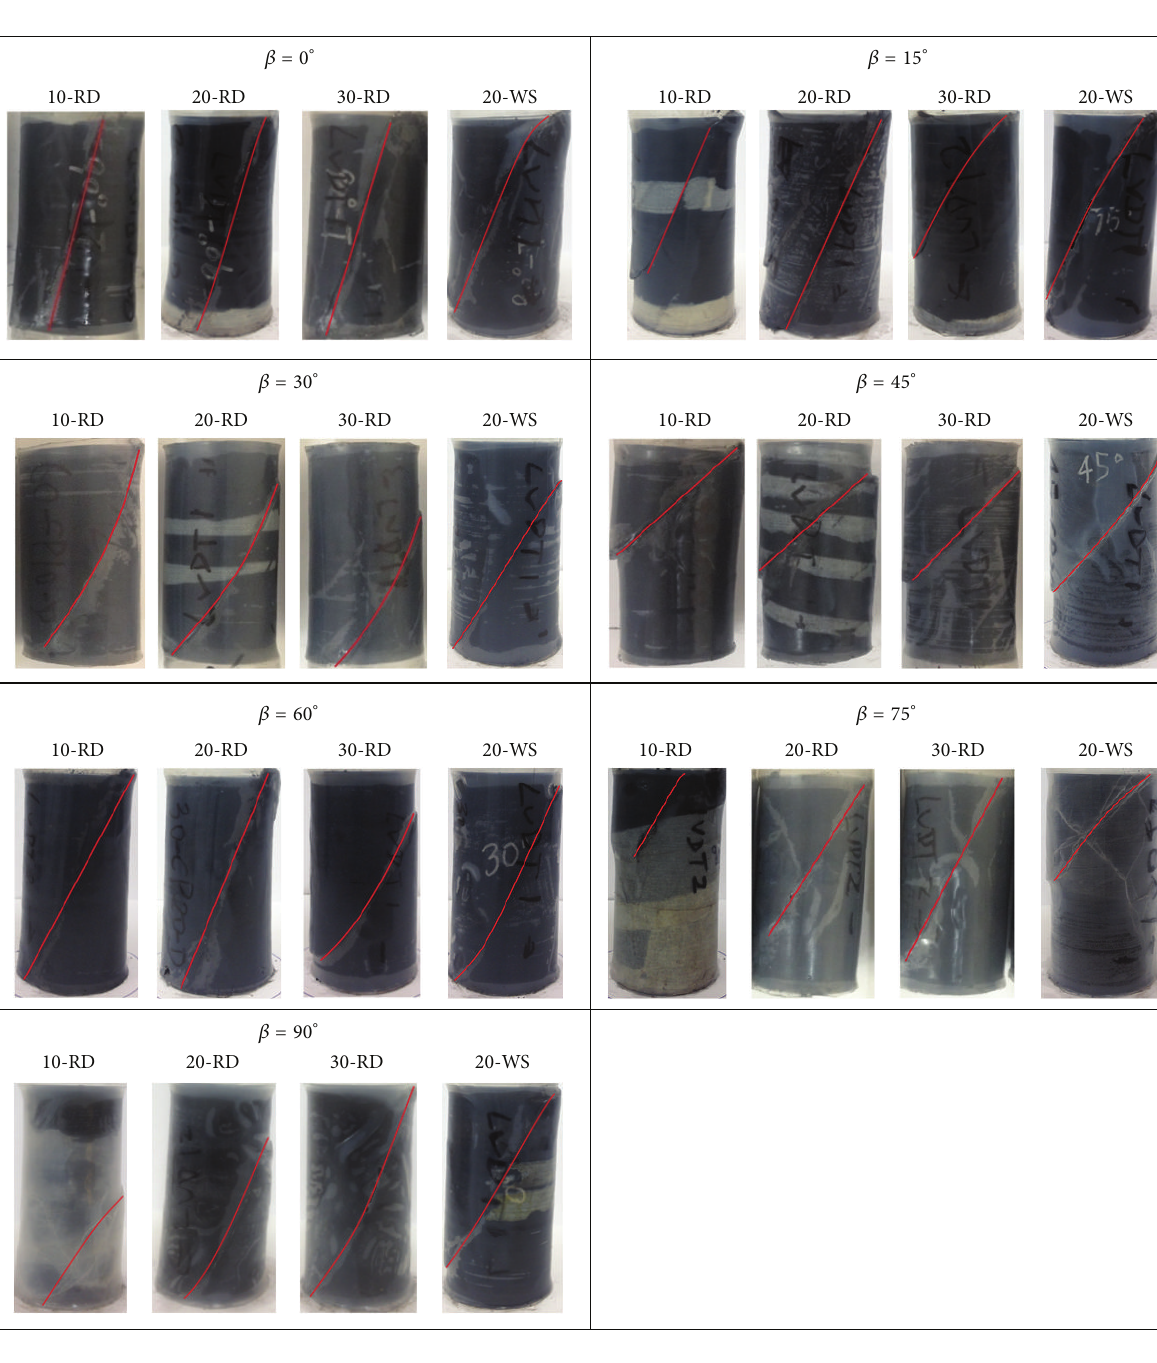
Figure 14: Photos of room dried samples at different 𝛽 under various confining pressures after